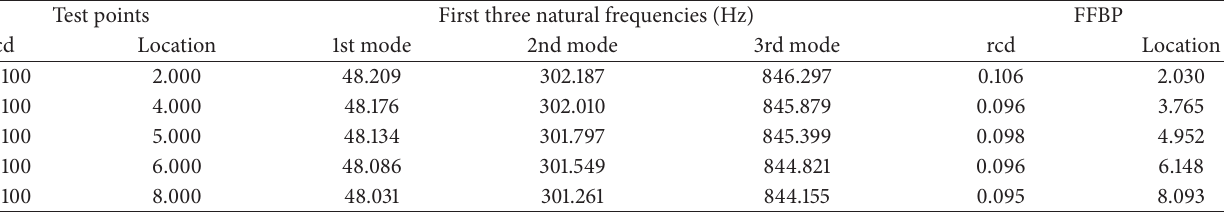
Table 2: Input data and results for FFBP network.